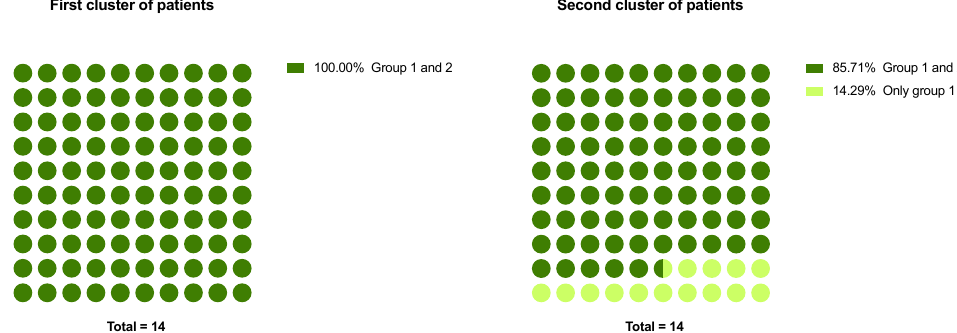
Figure 4. Frequency of occurrence of CTCs with different phenotypes in patients belonging to the first and second clusters. N-cad—N-cadherin, Vim—Vimentin.